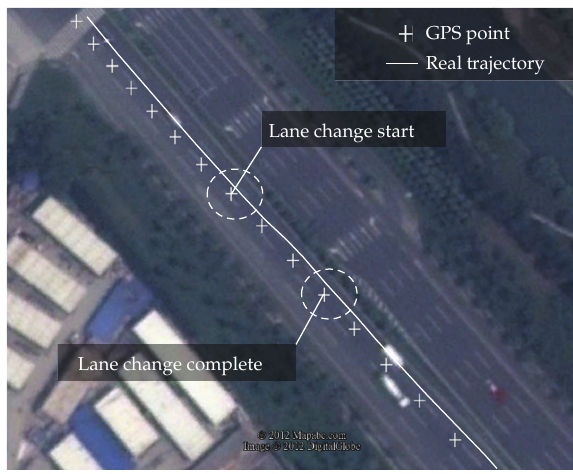
Figure 3: Dynamic positioning test of GPS.